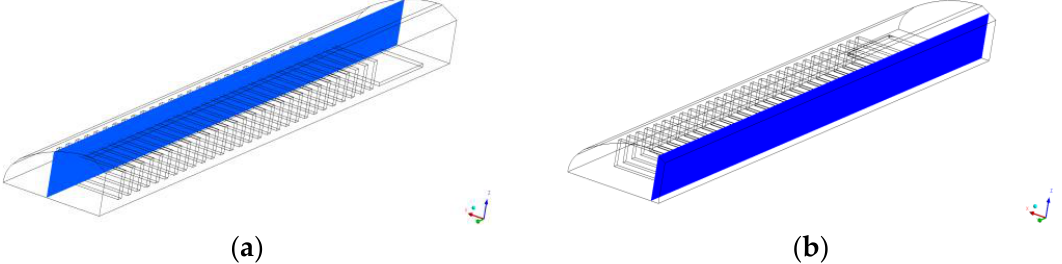
Figure 7. Solar greenhouse study cross-section: ( a ) x = 4000 mm (crop area); ( b ) x = 600 mm (non- crop area).